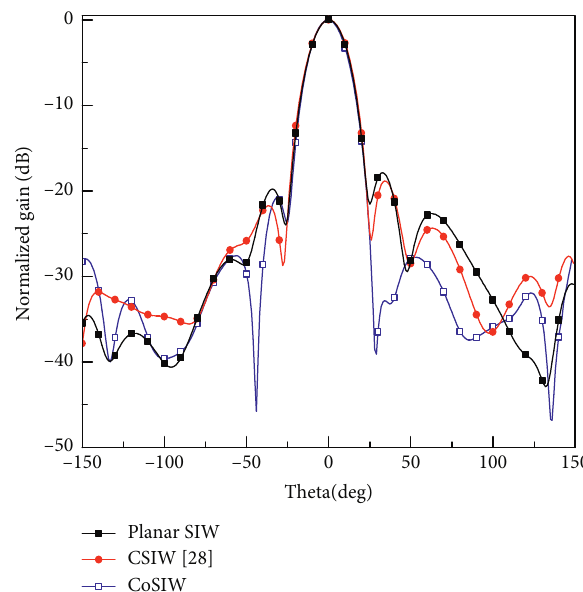
Figure 8: H-plane radiation characteristics of planar, cylindrical, and nose-cone conformal slot arrays. Table 3: Comparative analysis for planar, cylindrical, and nose-cone conformal SIW slot arrays ( N � 6 and d � λ Parameters Planar SIW Cylindrical SIW [28]